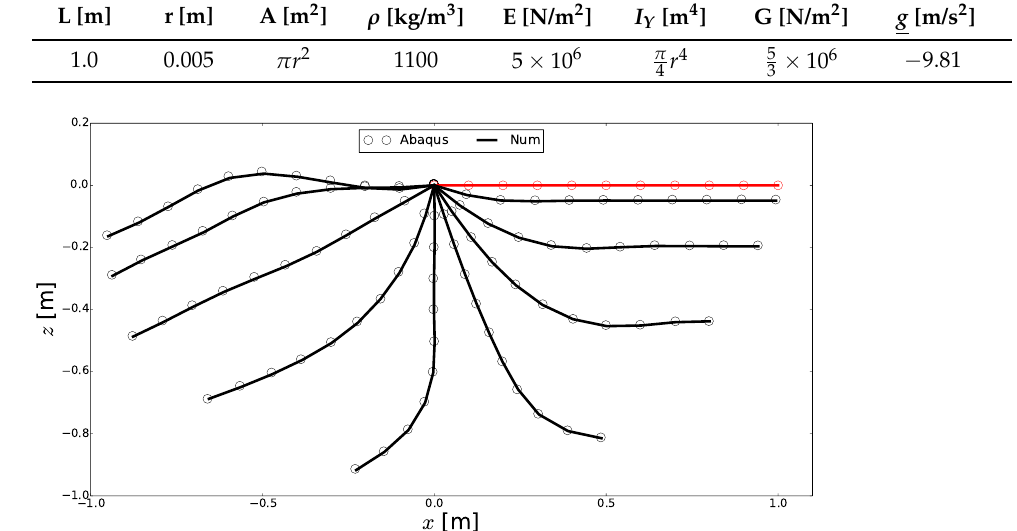
Figure 8. Deformation of a swinging elastic rod pinned at one end. The black lines show the deformed rod in 0.1 s time increments. The red line shows the initial position of the rod.